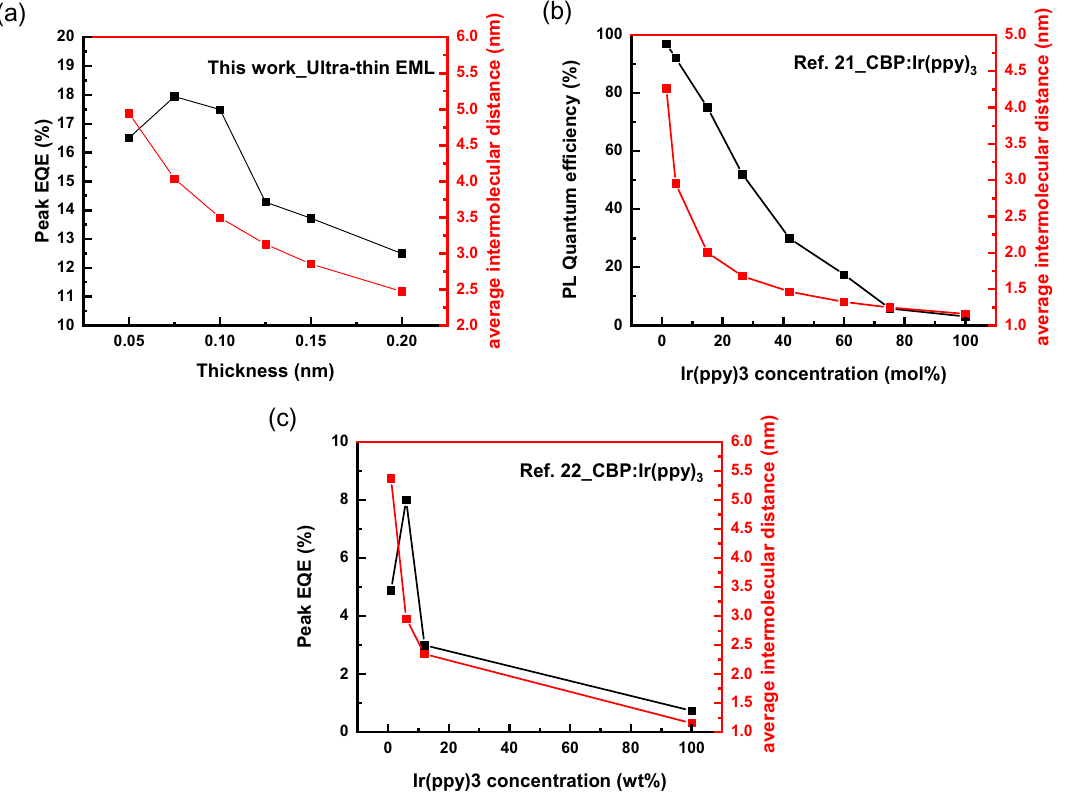
Figure 3. The relation between quantum efficiency and average dopant intermolecular distance according to the thickness of ultra-thin EML and doping concentration ( a ) this work, ( b ) reference 21 , and ( c ) reference 22 .